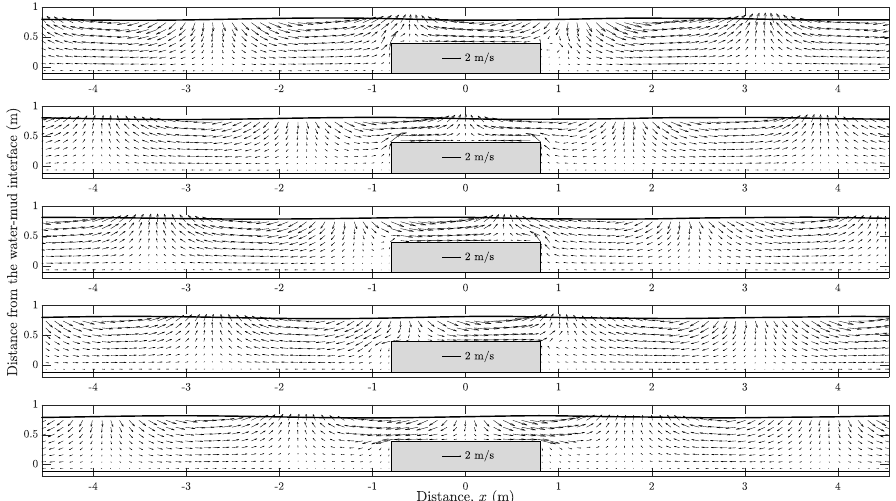
Figure 16. Bottom obstacle on a muddy bed with d m = 3 δ m : snapshots of velocity field over a wave period at t / T = 1 , 2 , 3 , 4 , and 5 (top to bottom). Solid line indicates the free surface. See Figure 13 6 6 6 6 6 for the model inputs.